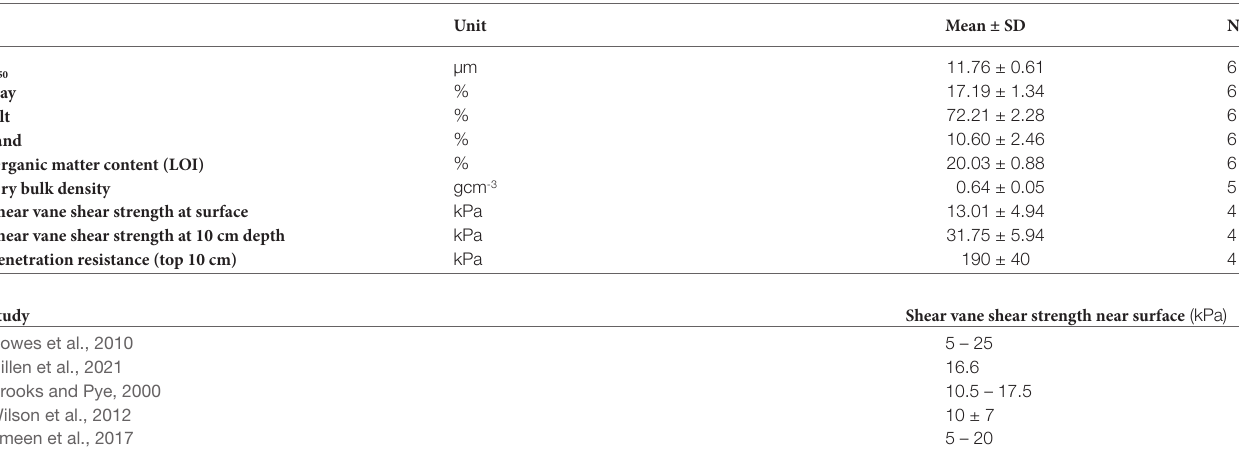
TABLE 2 | Overview of the sediment characteristics (A) at the extraction site presented as the mean, standard deviation ( SD ) and sample size ( N ). (B) Field studies with recording of shear vane shear strength measurements near the sediment surface in mature tidal marshes.